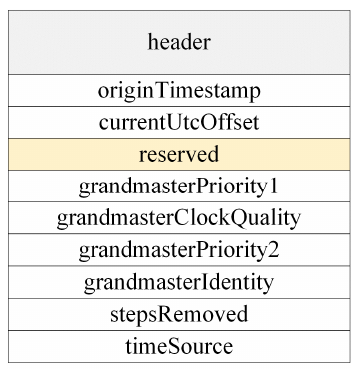
Figure 1. The structure of an Announce message.